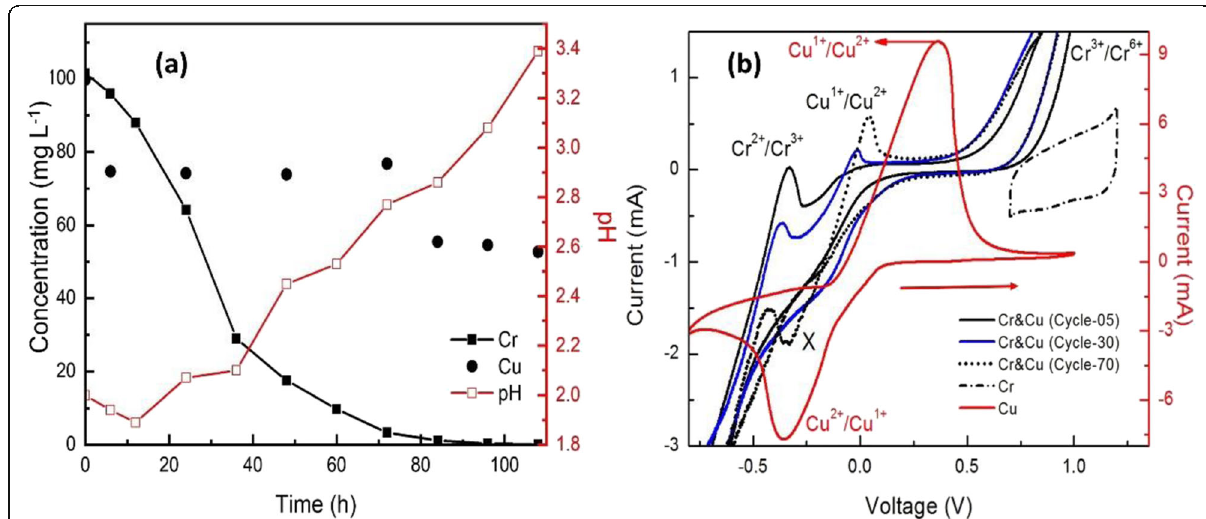
Fig. 2 a Temporal behavior of Cr 6+ and Cu 2+ and corresponding change in the pH value at pH 2; b Cyclic voltammograms of CC electrode in Cu 2+ , Cr 6+ , and Cr 6+ & Cu 2+ mediated solution at pH